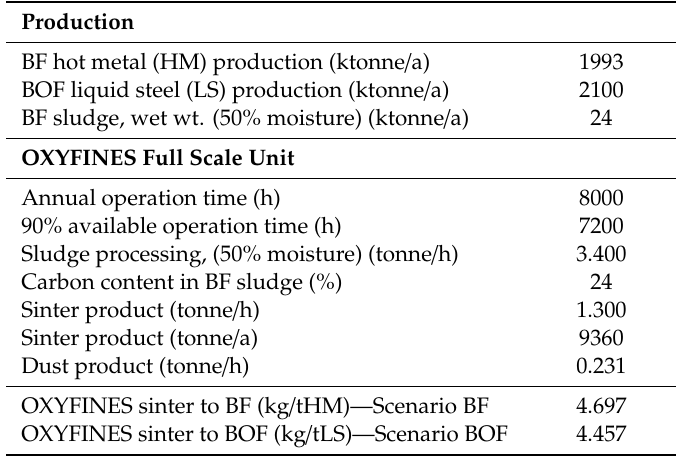
Table 1. System calculation basis with the integration of a full-scale OXYFINES